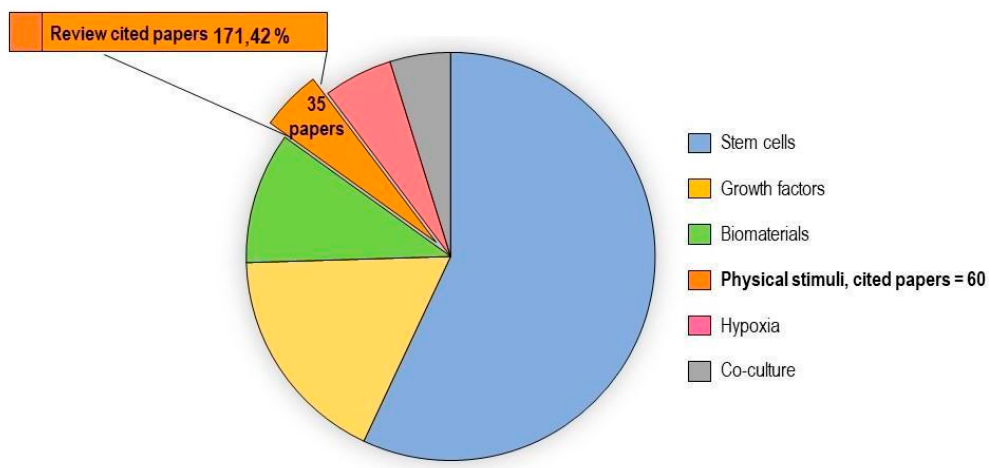
Figure 8. The orange section shows the percentage/number of papers available on the Scopus database obtained by combining key words in vitro stem cells tendon differentiation with physical stimuli. In the histogram, the relative percentage of the cited papers is expressed as well as the relative number in the legend.